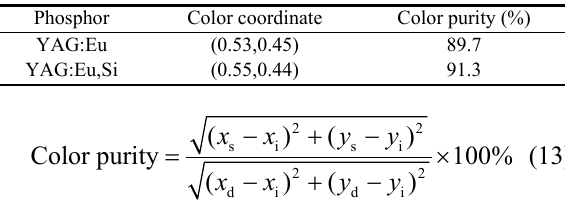
Table 4 Color characteristics of YAG:Eu/YAG:Eu,Si phosphors Phosphor Color coordinate Color purity (%) YAG:Eu (0.53,0.45) 89.7 YAG:Eu,Si (0.55,0.44)